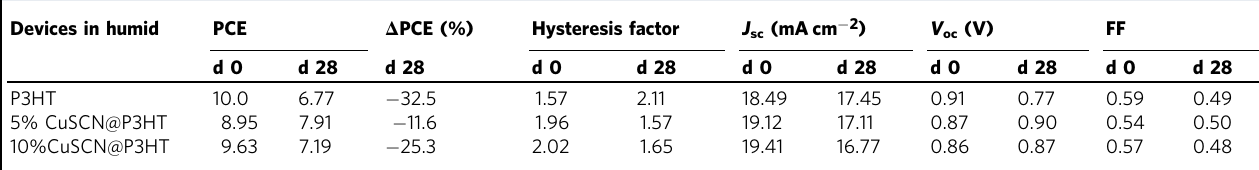
Table 1 Average fi gures of merit for PSC measured as prepared (d 0) and after 28 days (d 28), stored in a water-saturated atmosphere with RH > 80% ( “ humid ” environment).